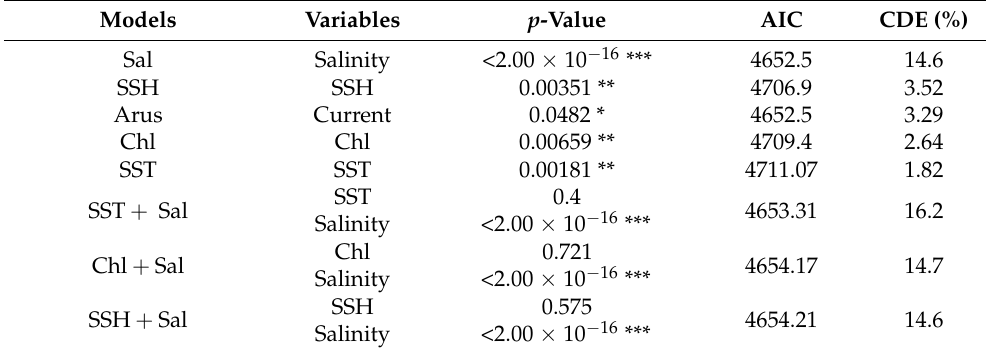
Table 2. GAM-derived Deviances and AIC